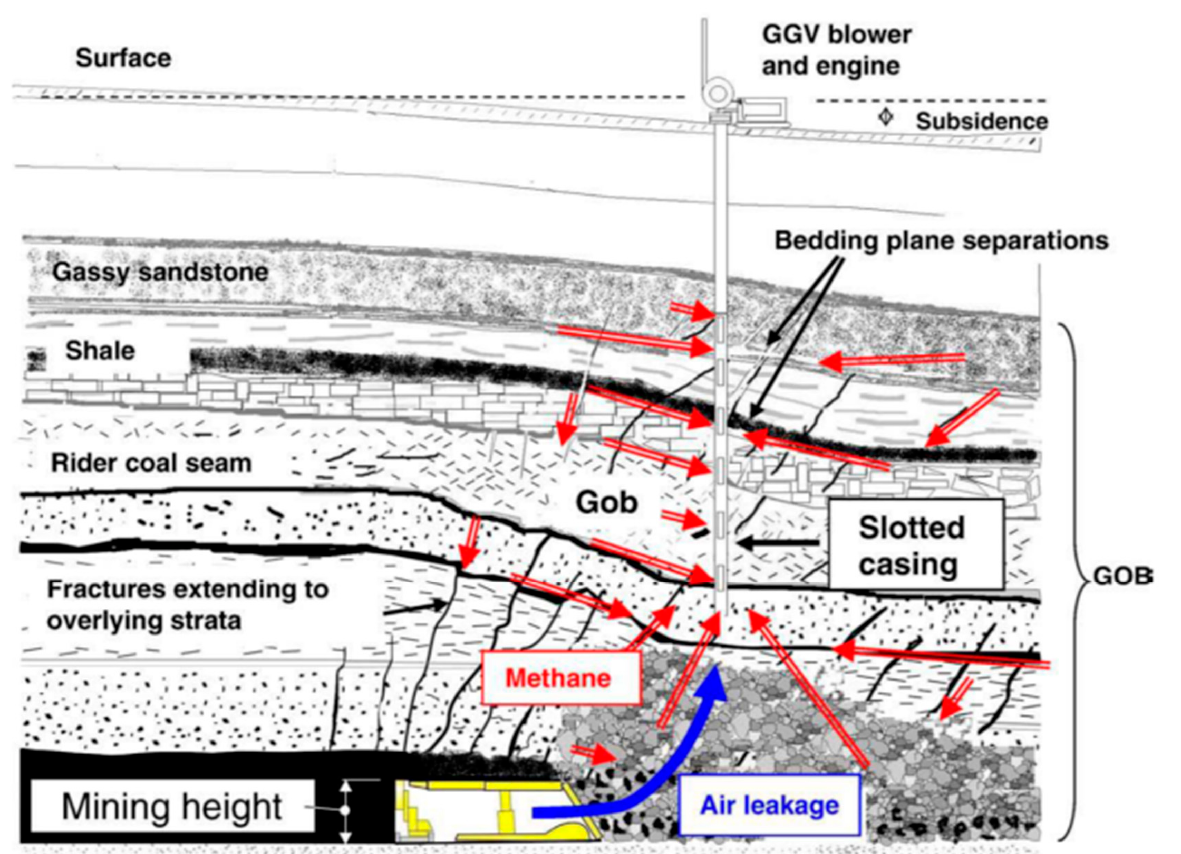
Figure 1. Schematic diagram of surface GGV [14].